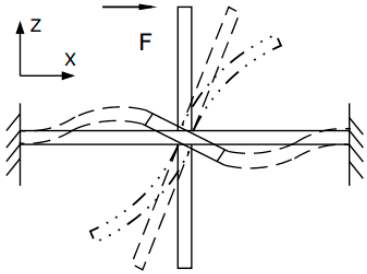
Figure 4. The stress situation of the sensitive microstructure.